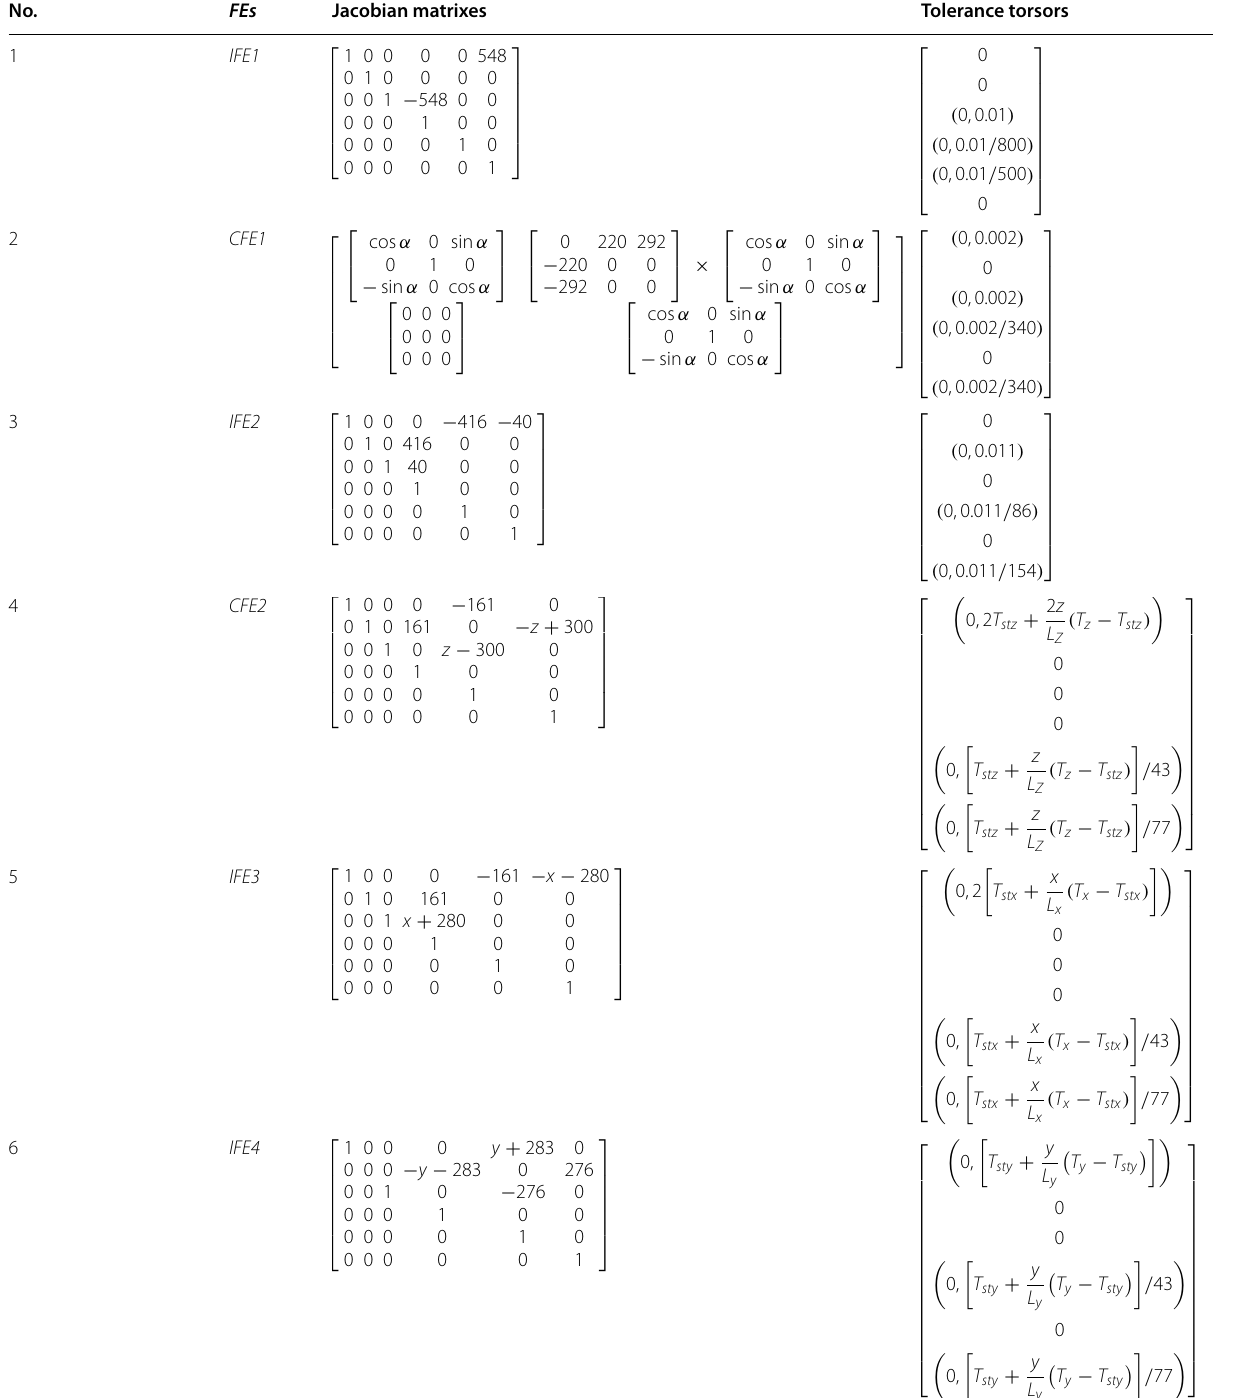
Table 4 Jacobian matrixes and deviation torsors No. FEs Jacobian matrixes Tolerance